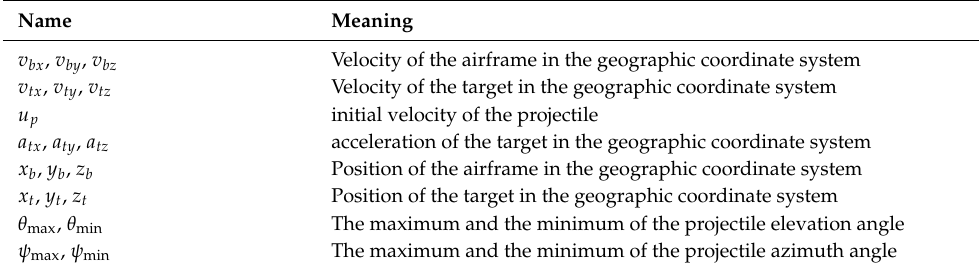
Table 2. The parameters of